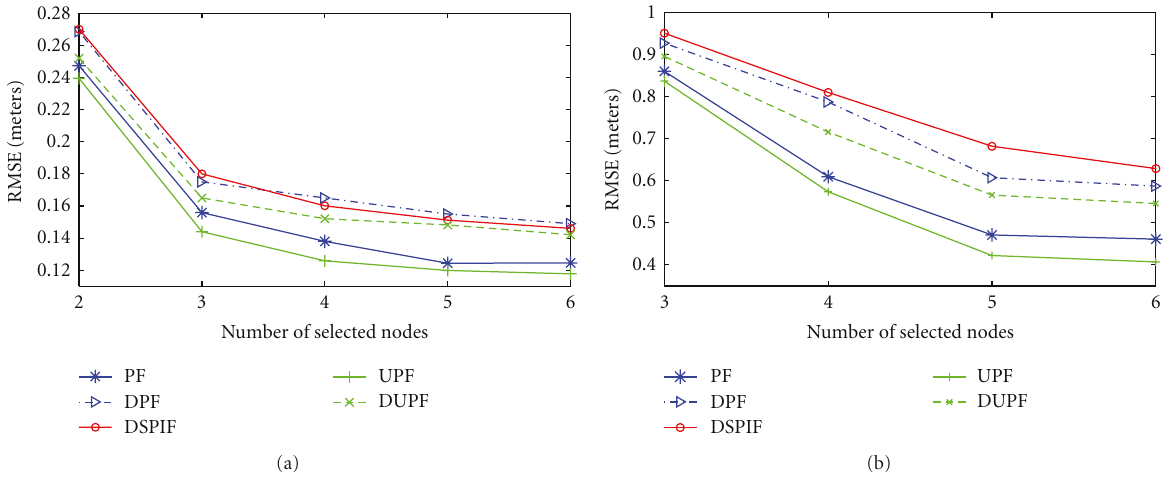
Figure 6: Performance accuracy comparison of particle filters: (a) target velocity = 0.1m/s, σ o = 0 . 3, and σ p = 1 . 0; (b) target velocity = 0.3m/s, σ o = 0 . 3, and σ p = 1 . 8